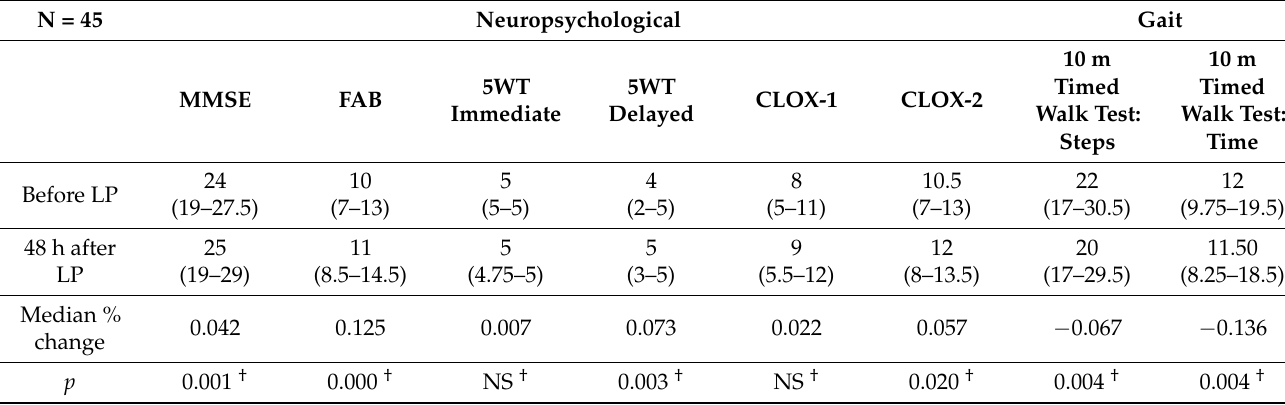
Table 1. Neuropsychological and gait data of studied